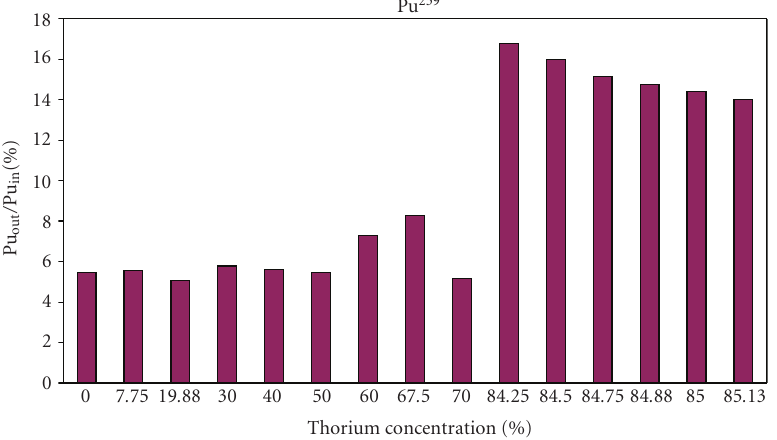
Figure 15: Pu 239 out /Pu 239 in versus Th concentration.